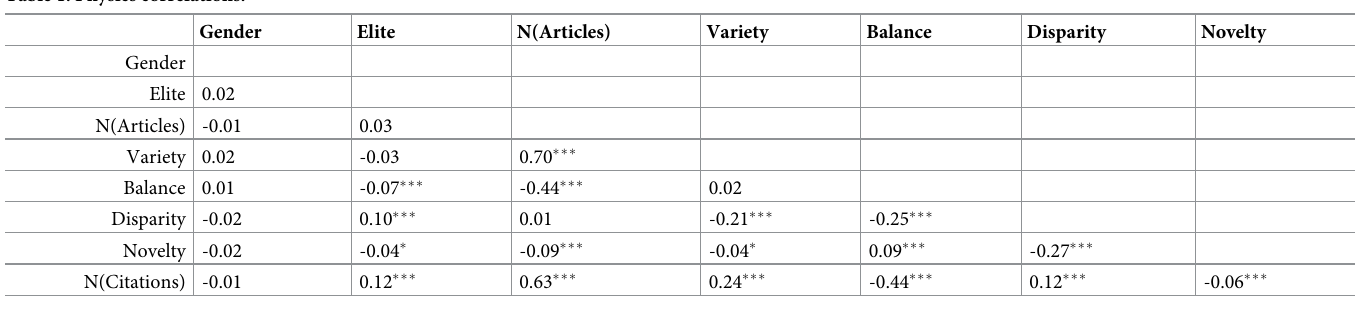
Table 1. Physics correlations.